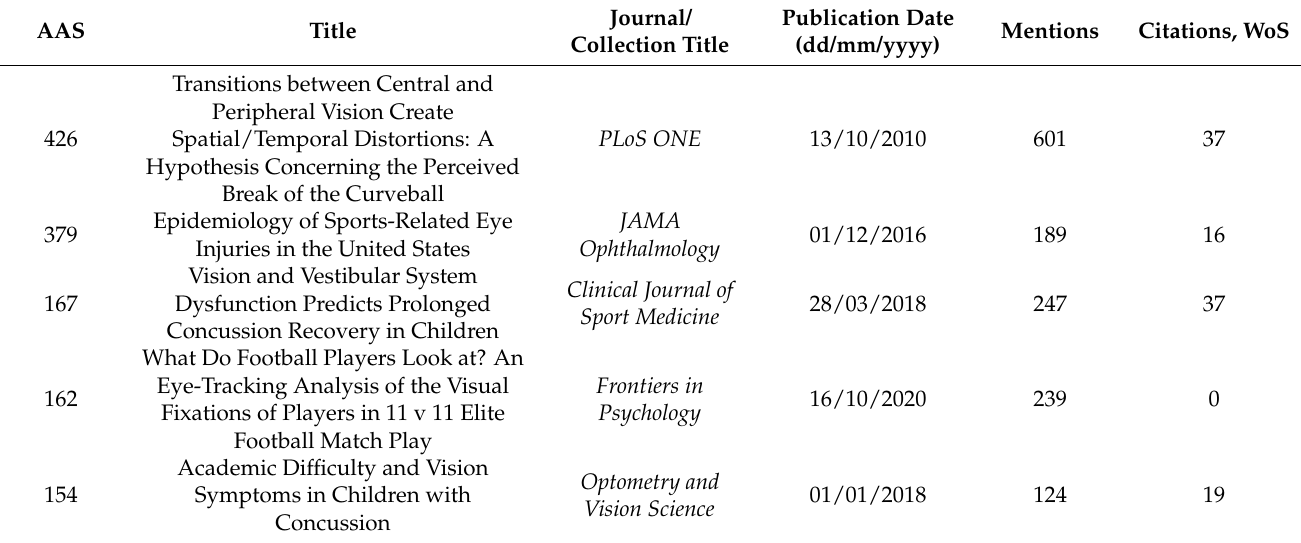
Table 5. Top five research outputs about sport vision according to the Altimetric Attention Score (AAS).